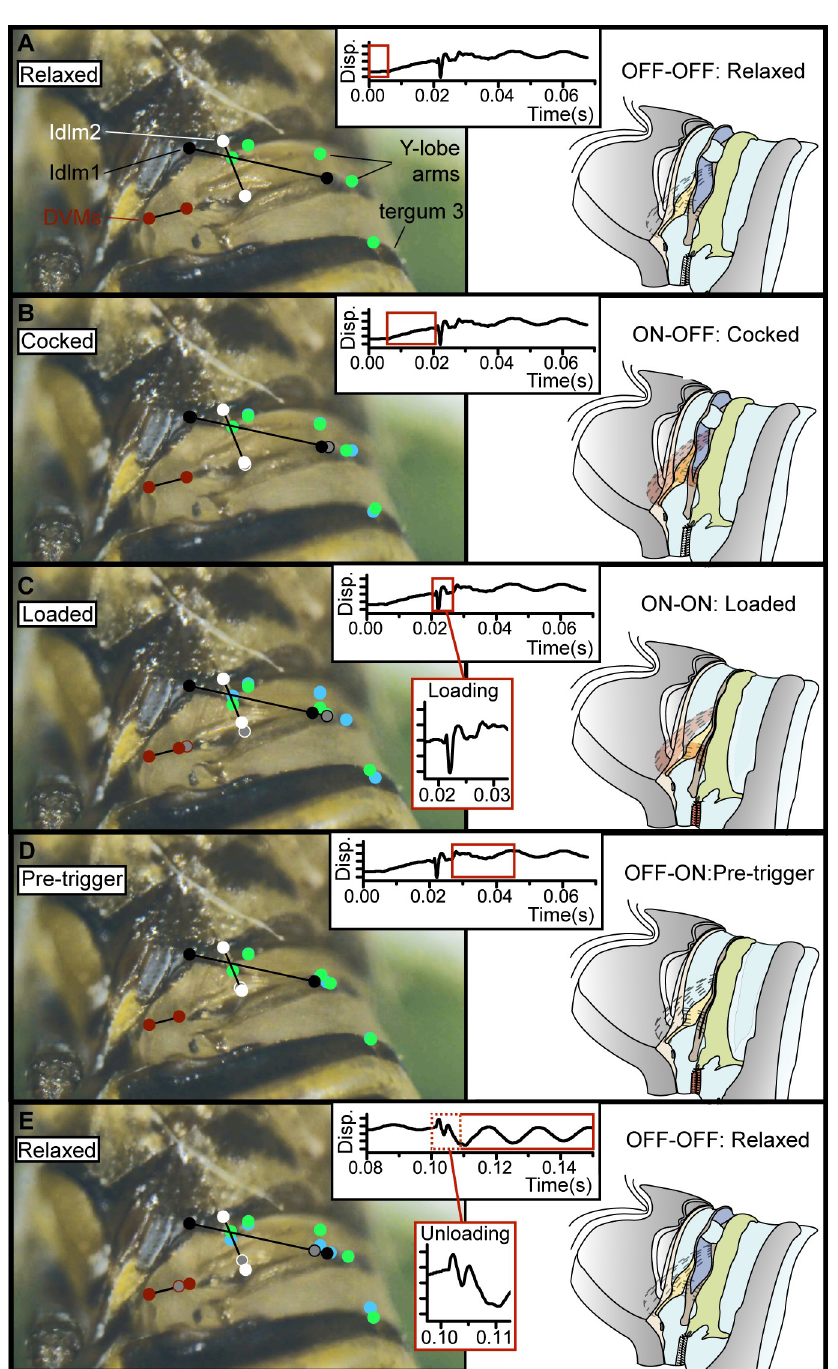
Fig 4. Stages of snapping organ mechanism in a male A . bilobum , illustrating external landmarks used to infer muscle strains internally (left) with corresponding stages of proposed mechanism shown diagrammatically (right). Muscle action was inferred from high-speed videography and laser vibrometry in conjunction with a separate microscopic study of the musculoskeletal anatomy to identify their origins and insertions (centre inset: Disp. of prothorax against time in seconds for one sample recording; identical axes on each panel): (A) relaxed, (B) cocked, (C) loaded, (D) pretrigger, (E) relaxed. (C) and (E) also have insets showing vibrometry recording for loading and unloading, respectively (Disp.–time). Origins and insertions of snapping organ muscles are symbolised by coloured circles (black: Idlm1; white: Idlm2; red: DVMs IIedvm1-IIedvm2). Muscle IIdlm is not included because the area it occupies does not undergo any noticeable change during stages (A)–(E) and is unlikely to contribute to the